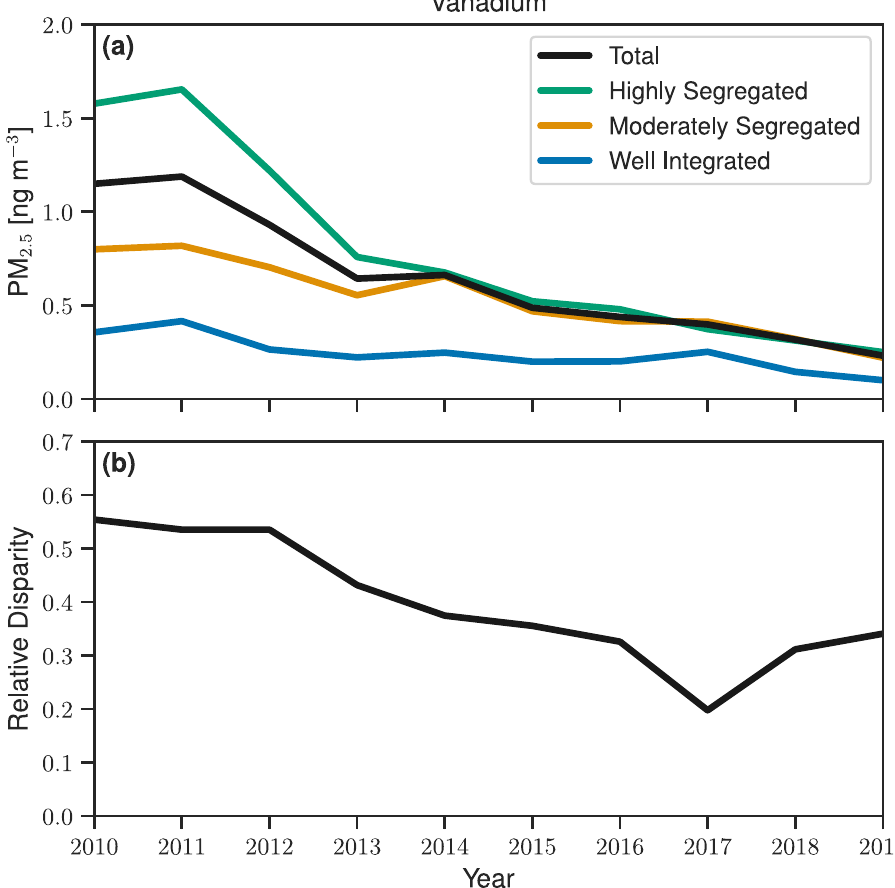
Fig. 4 | Decreasing temporal trends in Vanadium disparity. a Population-weighted annual mean V concentrations and b relative V disparity across RRS